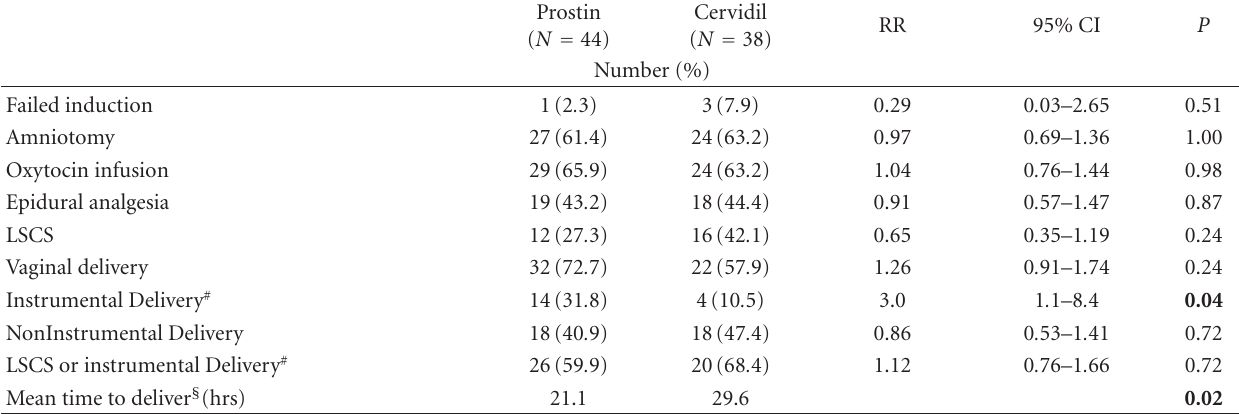
Table 2: Maternal outcomes following Induction of labour with Prostin or